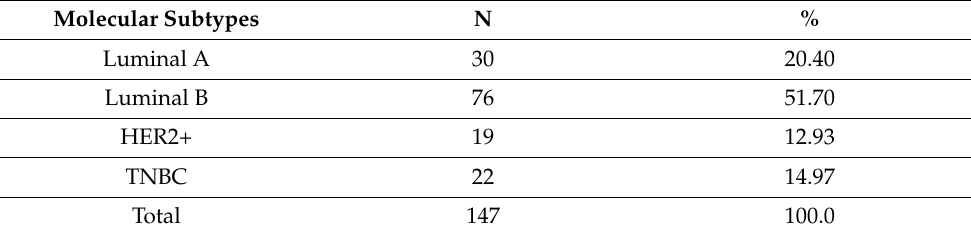
Table 2. Frequency of IBC molecular